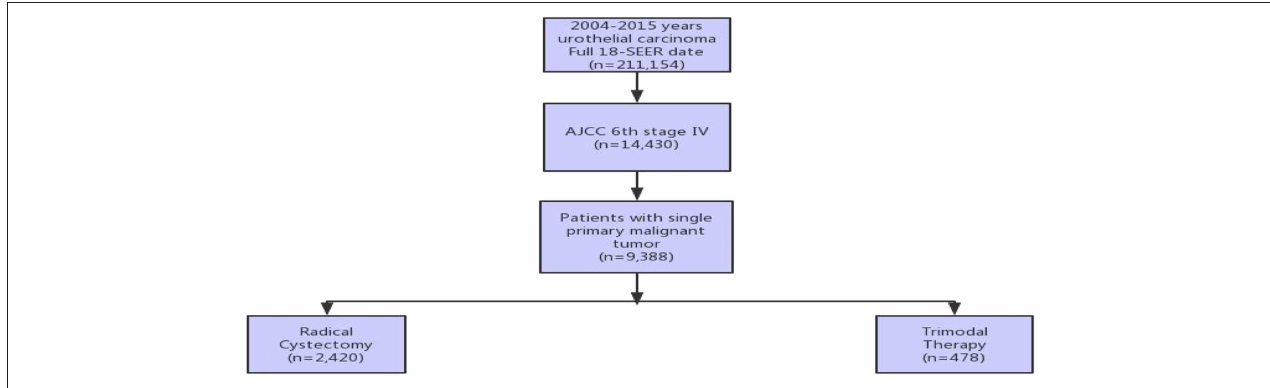
FIGURE 1 | Illustration of patient selection process.